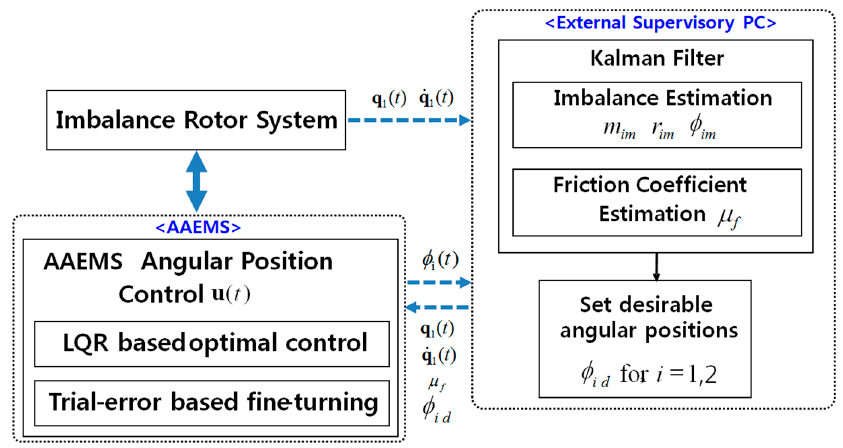
Figure 2. The estimations and control scheme of AAEMS in an imbalanced rotor.